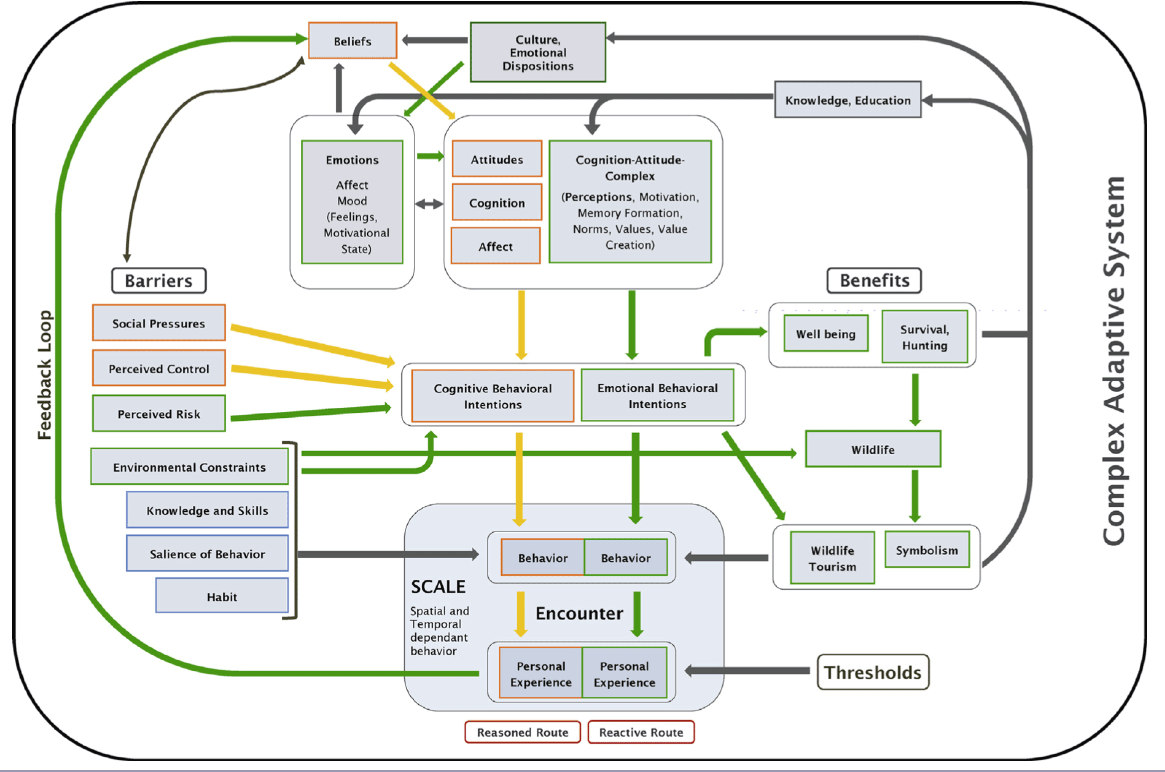
Fig. 1 . The integrated adaptive behavior model (IABM) of human-wildlife encounters. From Jochum et al. (2014:80), Figure 2: “Yellow/light gray markings refer to components that derived originally from the Theory of Reasoned Action and the Theory of Planned Behavior. Green/medium gray markings refer to theories developed in emotions toward wildlife research. Blue/dashed marks additional components recognized in the Integrated Behavioral Model. Dark gray markings are based on Complexity Theory and components were connected by the authors. The importance of scales is displayed as overarching. The Reasoned and Reactive Route concept is based on Fuzzy Trace Theory. The Reasoned Route is based on cognitive principles (yellow/light gray arrows); the Reactive Route is based on emotional principles (green/medium gray arrows). Inhibitory and excitatory links between emotions and cognition are based on The Parallel Constraint Satisfaction